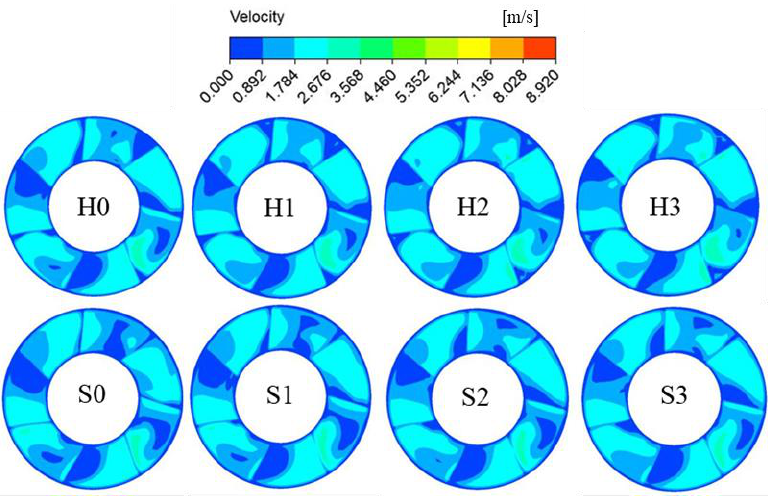
Figure 8. Velocity distribution at the outlet of the guide vane.